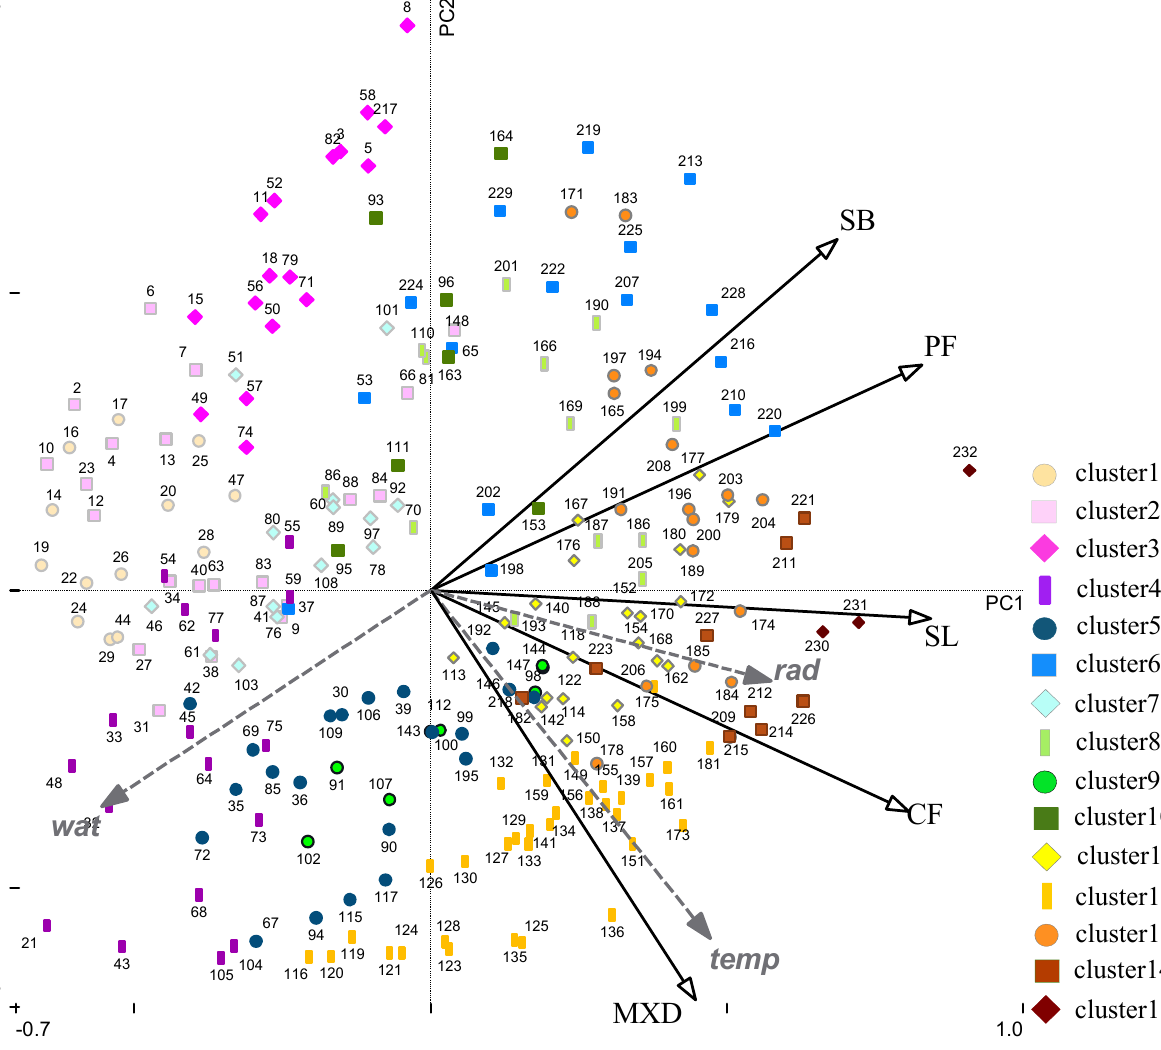
Figure 3. Ordination triplot of the gradient PCA analysis. The icons represent the 232 EFTs (numbers) classified into 15 clusters (icons). Full arrows represent the Phenolo variables (see Figure 1) whereas dashed arrows show climatic constraints of vegetation growth ( wat = water, temp = temperature, rad = radiation). The horizontal axis shows the first PCA axis (55.9% variation explained) whereas the vertical axis shows the second axes (23.2% variation